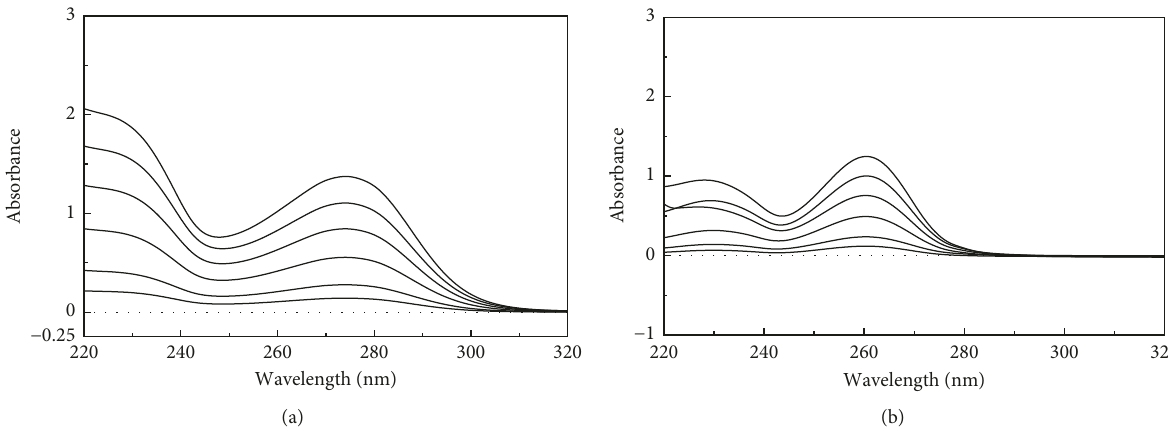
Figure 3: Overlay of the zero-order absorption spectra of TRG (5, 10, 20, 30, 40, and 50 µ g/mL) (a) and TAD (2.5, 5, 10, 15, 20, and 25 µ g/mL) (b), using methanol as a blank. Table 1: Results obtained by the proposed simultaneous equation spectrophotometric method for determination of TRG and